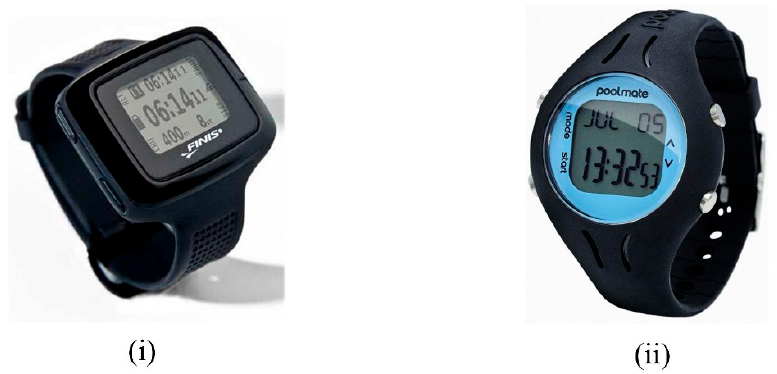
Figure 29. Commercially available swimming sensor devices: ( i ) FINIS SwimSense [136]; ( ii ) Swimovate PoolMatePro [138].